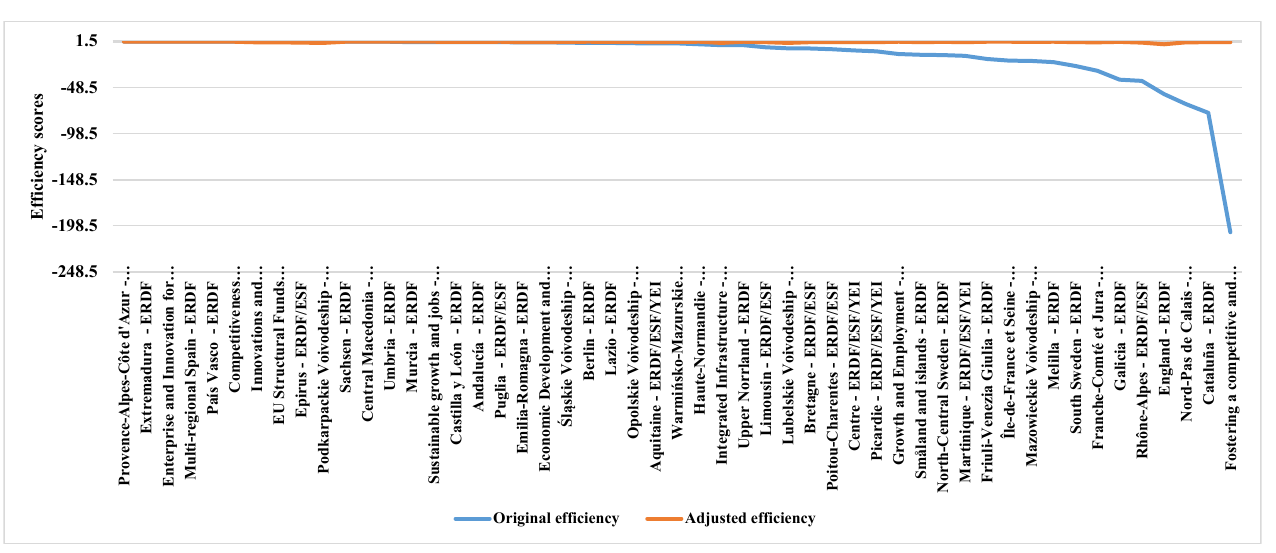
Figure 7. Original vs. adjusted efficiency scores. When contrasted with the first stage, “Melilla—ERDF”, “Île-de-France et Seine— ESF/ERDF/YEI”, and “Friuli-Venezia Giulia—ERDF” showed the largest increase in efficiency, with their values rising from − 21.05 to 1.02 (105%), − 19.60 to 1.03 (105%), and − 17.78 to 1.02 (84%), respectively—see Figure 8 and Table 12. These findings suggest that